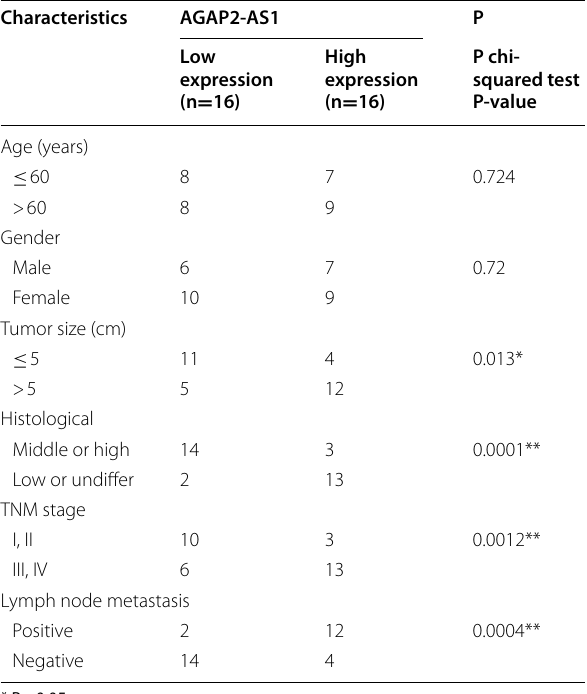
Table 1 Relationships between AGAP2-AS1 expression and clinicopathological characteristics of CCA